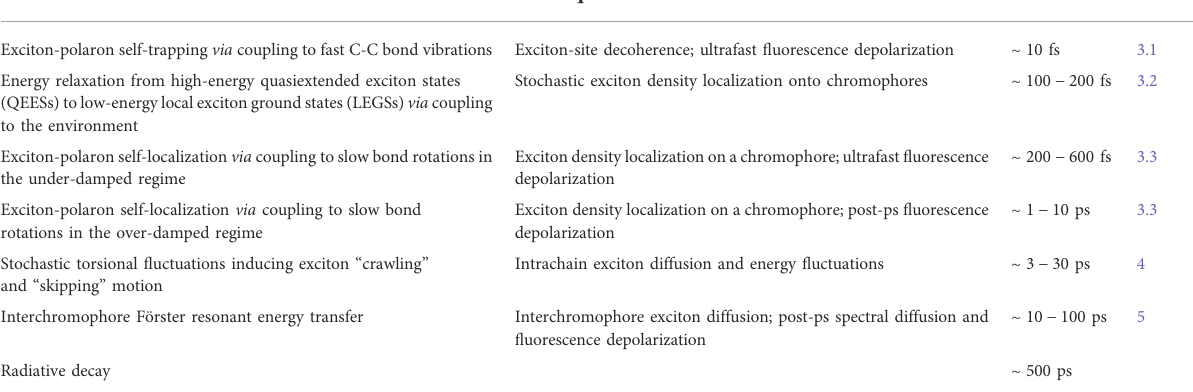
TABLE 2 The life and times of an exciton: Some of the key exciton dynamical processes, encompassing over four-orders of magnitude in time that occur in conjugated polymer systems.